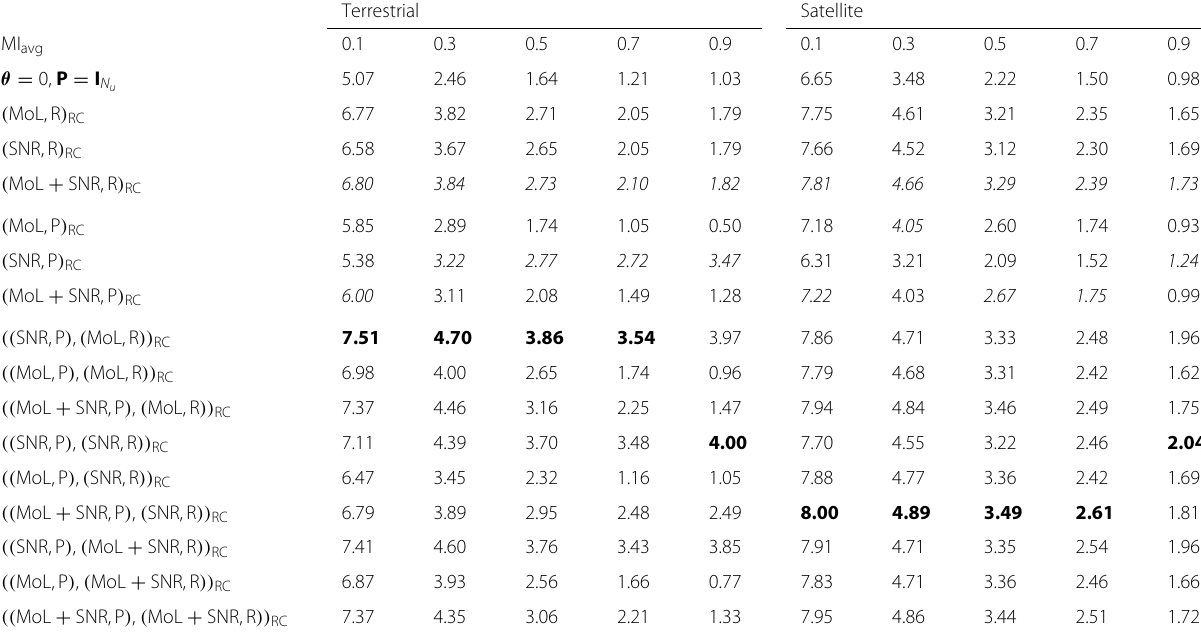
Table 3 SNR gain (dB) of the AD for 2-PAM Terrestrial